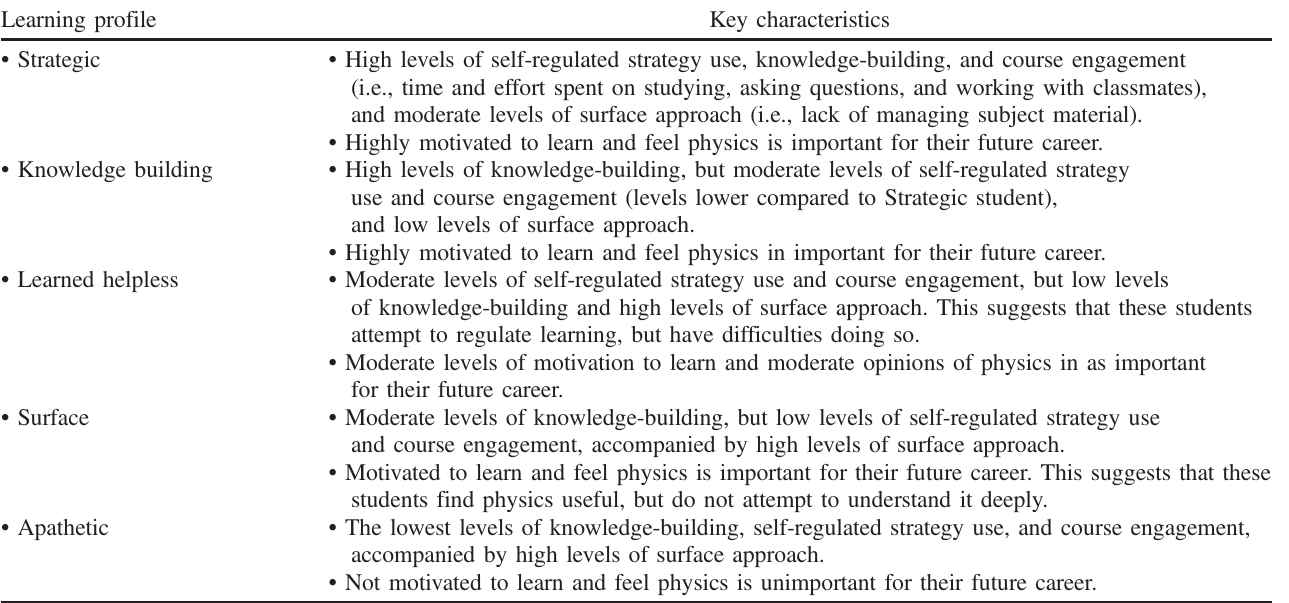
TABLE V. Synthesis of learning profile key characteristics. Learning